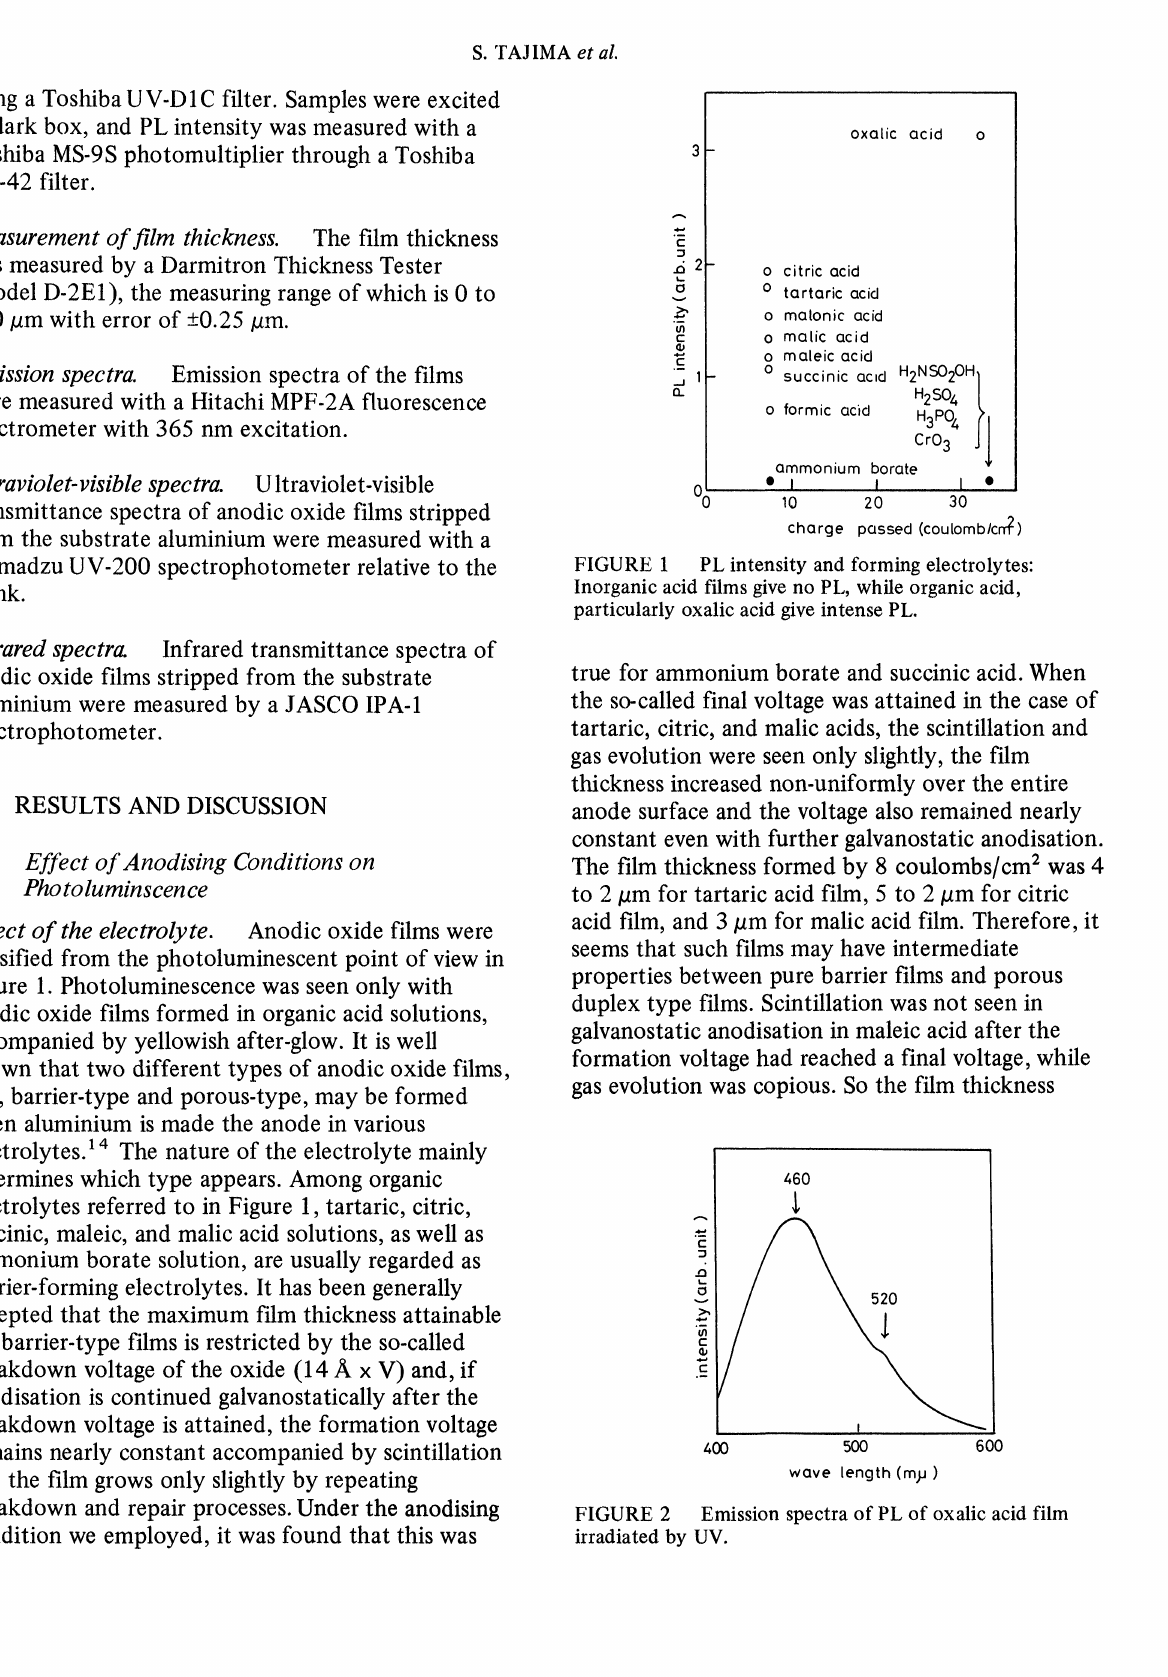
Emission spectra of PL of oxalic acid film irradiated by